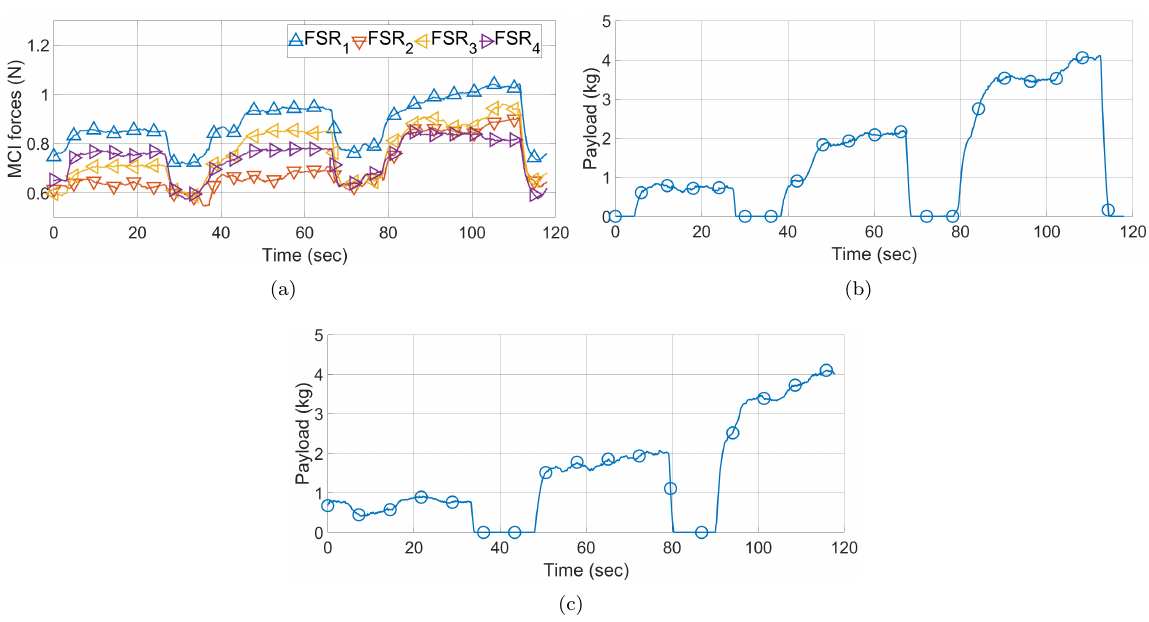
Figure 7: Payload estimation testing results, (a) MCI forces measured by sensor band for a configuration of θ e = 76 ◦ and θ s = 34 ◦ , (b) payload estimated for case (a), and (c) payload estimated for a configuration of θ e = 76 ◦ and θ s = 52 ◦